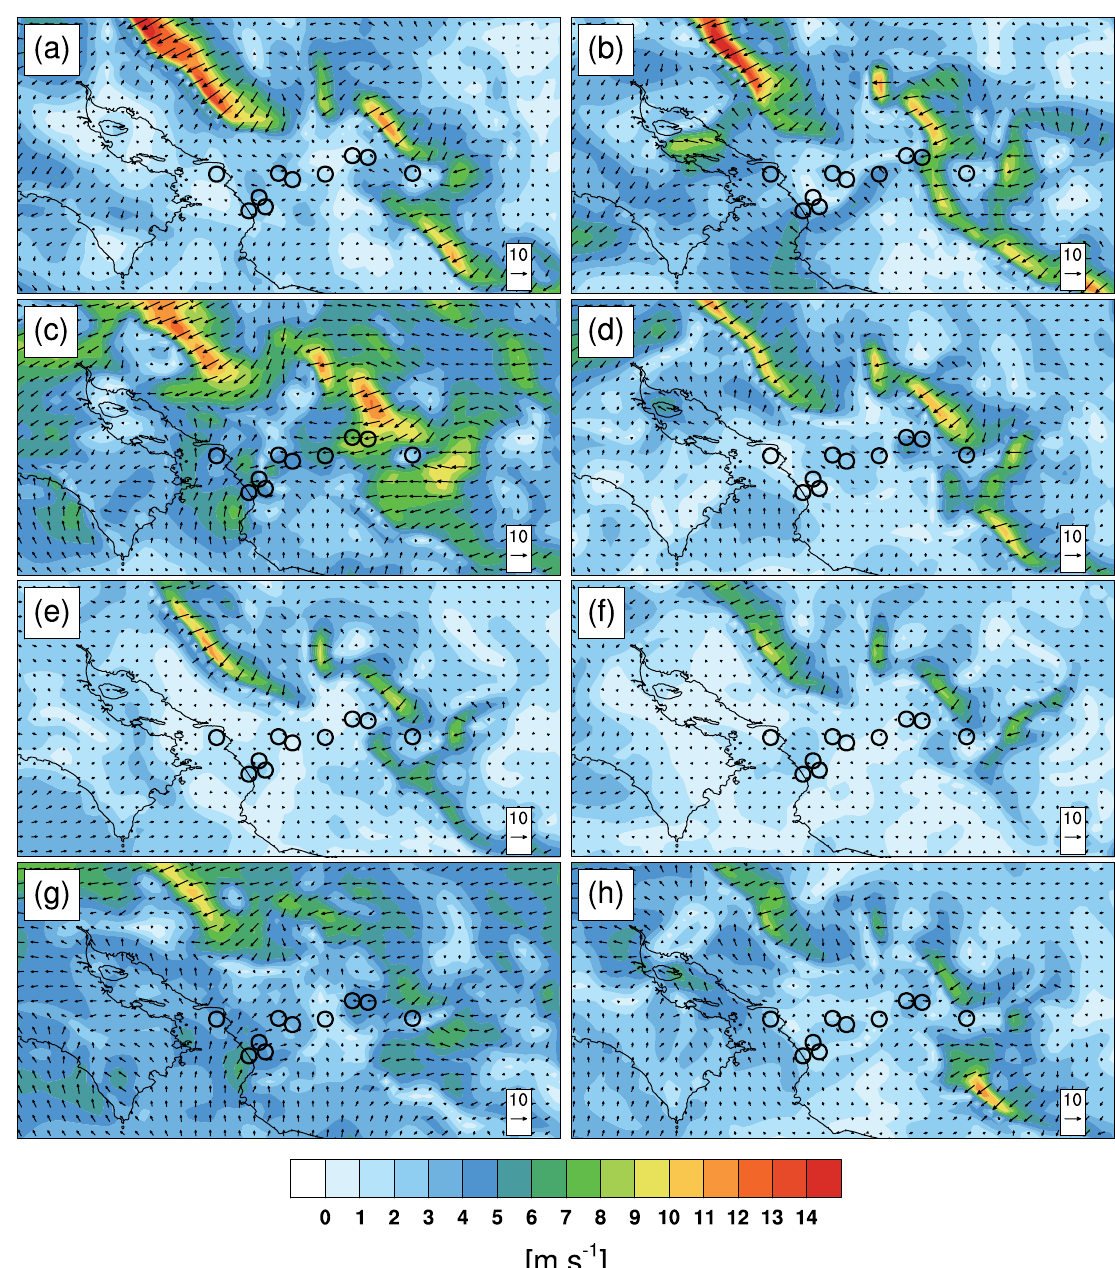
Figure 5. Simulated (GrMRF, D3) 10-m wind (m s − 1 ) for 11 July 2004 and 1 September 2004 at 00:00 LST ( a , e ), 06:00 LST ( b , f ), 12:00 LST ( c , g ), and 18:00 LST ( d , h ). The circles denote the location